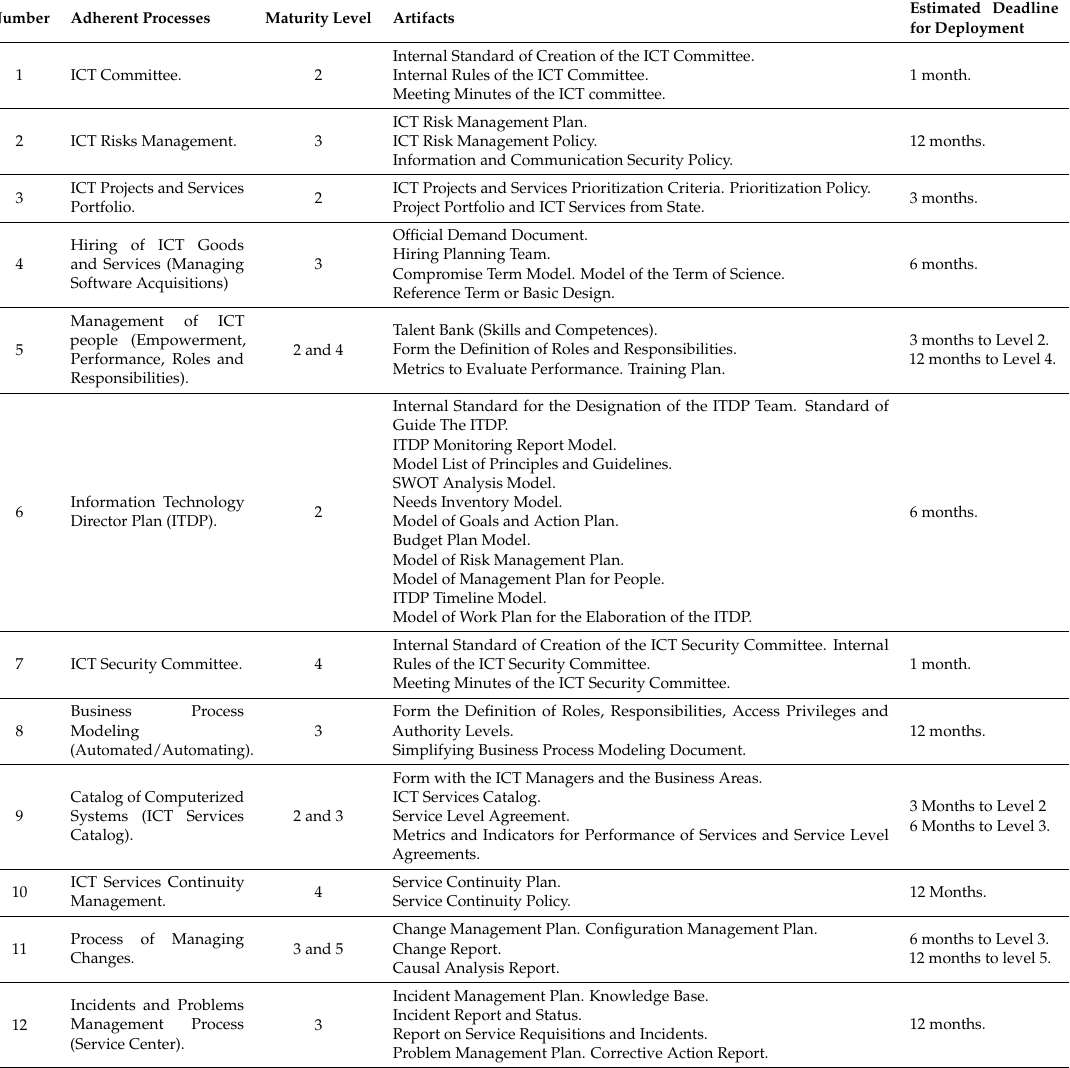
Table 2. Processes of the State Governance